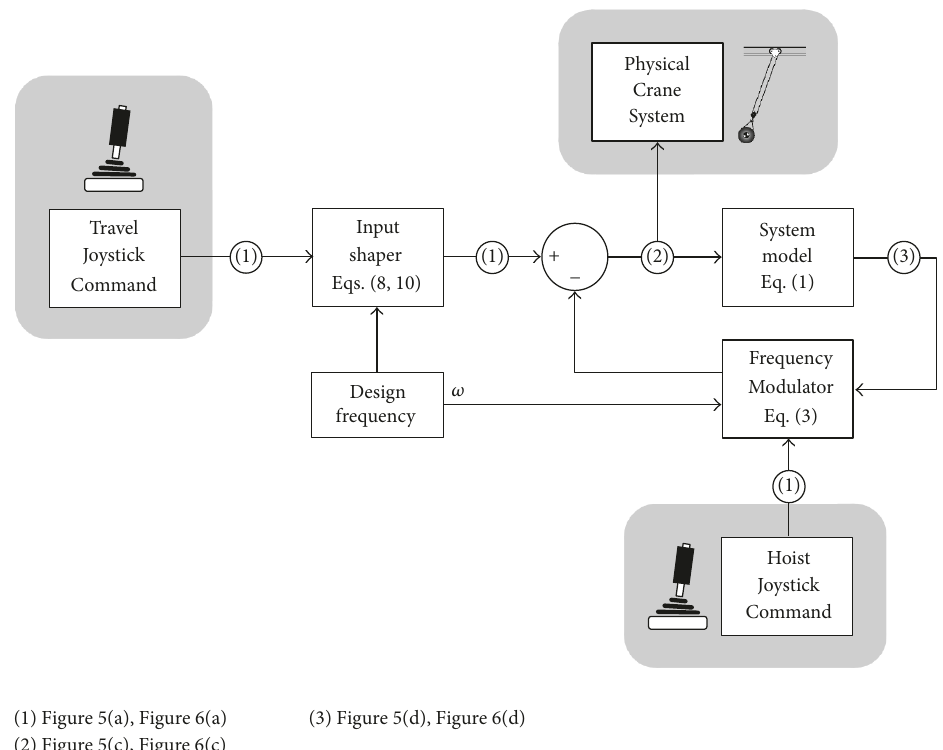
Figure 2: Schematic block diagram of the frequency modulation input